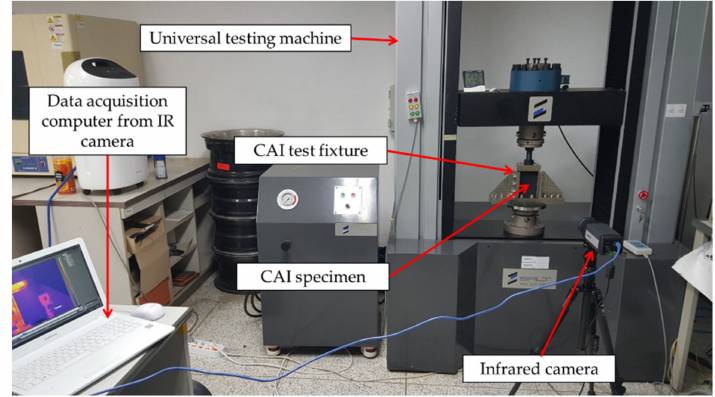
Figure 3. Compression after impact (CAI) experimental